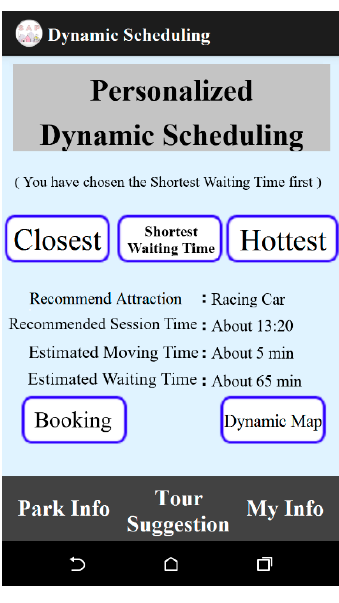
Figure 8. Experimental results of the Shortest Waiting Time First strategy.